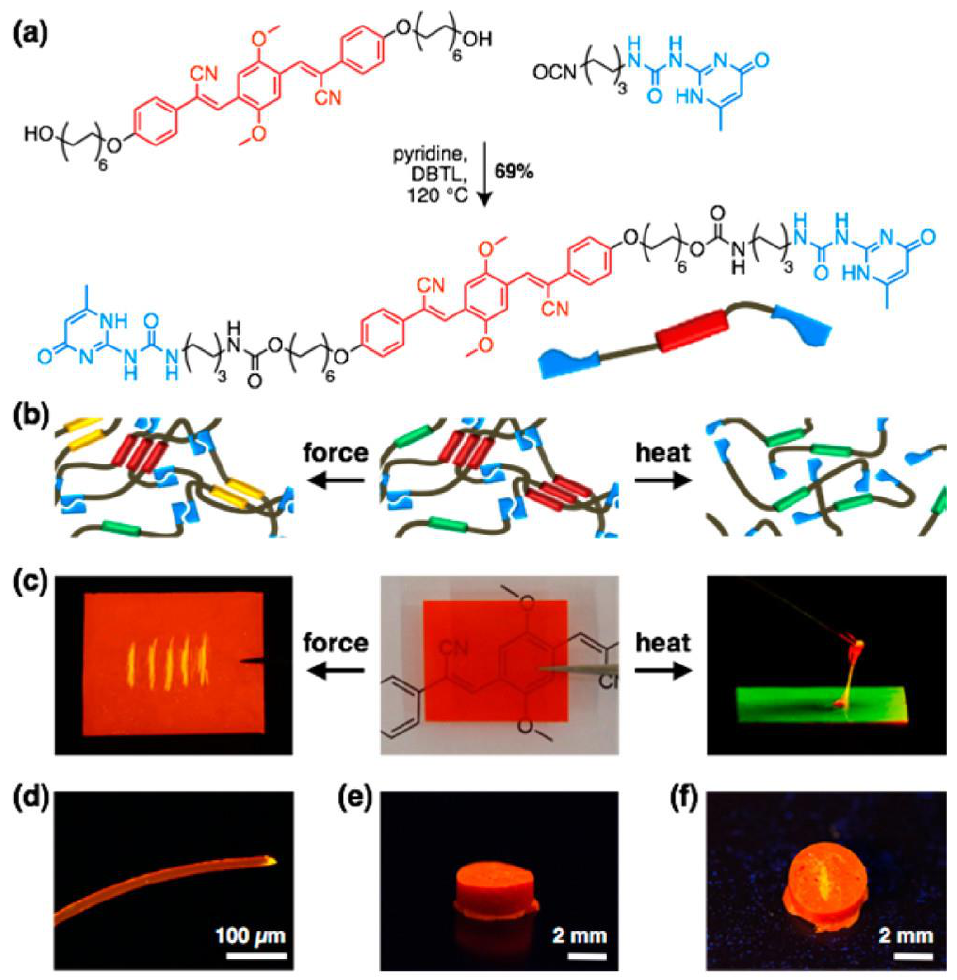
Figure 3. ( a ) Synthesis of the UPy-functionalized cyano-OPV. ( b ) Schematic of supramolecular assemblies. ( c ) Pictures of films made from the UPy-functionalized cyano-OPV, illustrating mechano- (left) and thermoresponsive (right) luminescent behavior. The fluorescence changes from red to yellow upon scratching (left). Upon heating (180 °C), a viscous green-light-emitting fluid is formed, which solidifies into a red-light-emitting solid when cooled (right). ( d ) Fluorescence microscopy image of a fiber made from 2; note the yellow fluorescing severed edge. ( e,f ) Photographs of a cylinder made from the UPy-functionalized cyano-OPV before ( e ) and after ( f ) scratching its surface. Images displaying fluorescence were recorded under illumination with 365 nm UV light. Adapted with permission from reference [69]. Copyright 2017, American Chemical